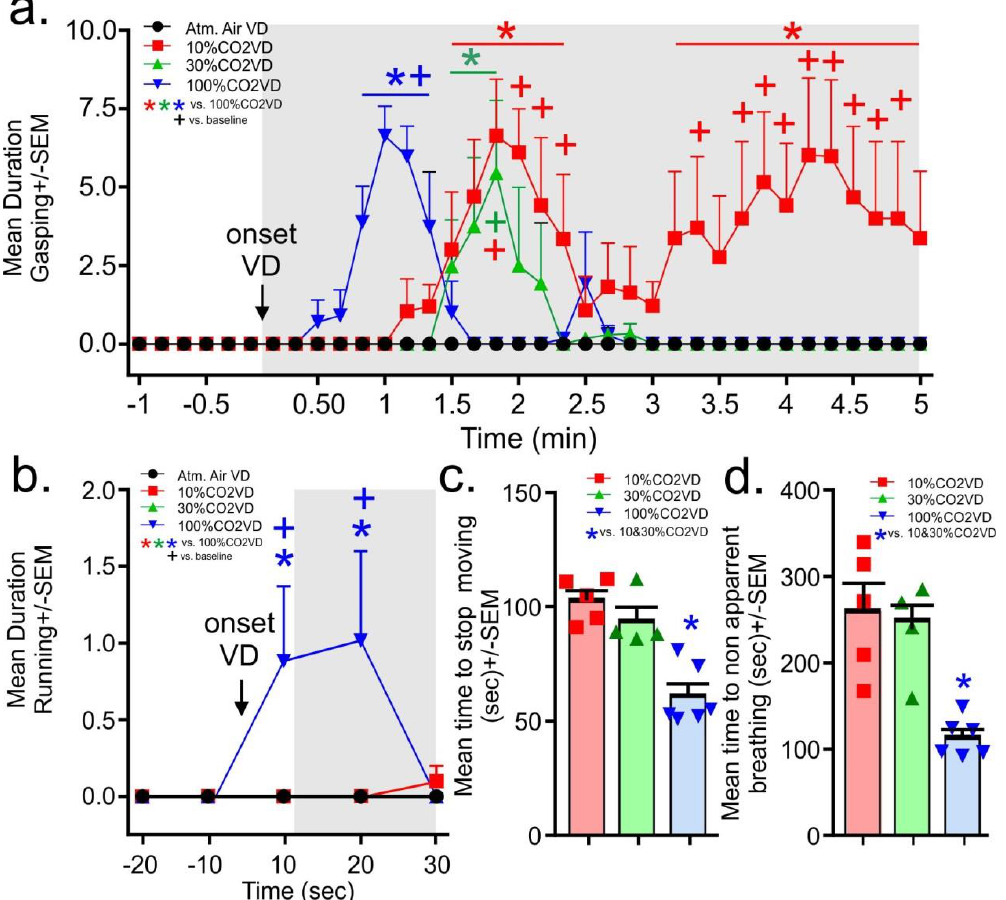
Figure 3. Line graphs in ( a,b ), respectively, represent the mean duration of gasping behaviors and running behaviors just prior to and following gas VP (gray shaded region). * represents between-subject significance p < 0.05 with a Fisher’s LSD post hoc test protected by a significant one-way ANOVA with gas treatment as the main factor and time as a repeated measure; ( c ) bar graph represents the mean time before the rat stopped moving; and ( d ) bar graph represents the mean time before breathing became non apparent. Individual points in c-d represent actual values of each animal. * represents a Fisher’s LSD post hoc test protected by a significant ANOVA.